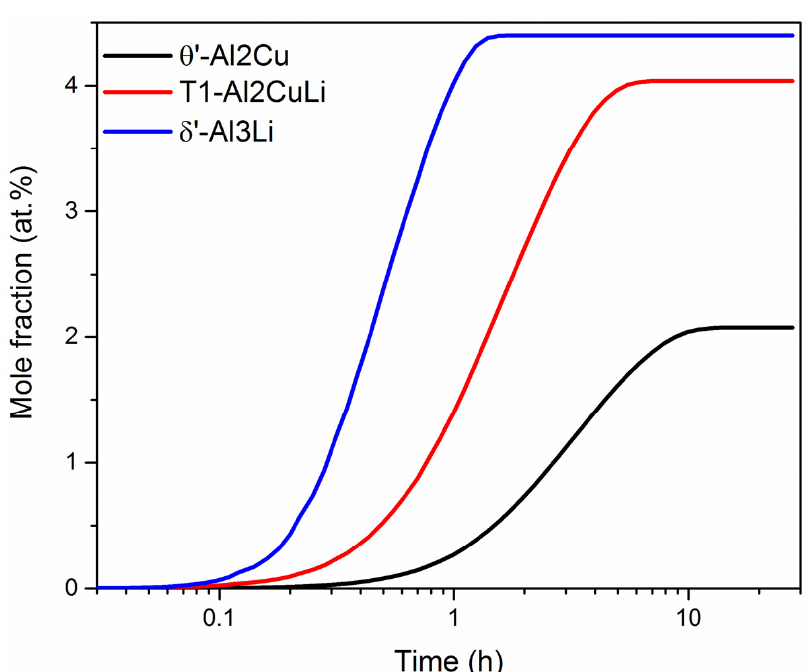
Figure 16. The kinetic curves of 2A97 alloy at 165 °C.